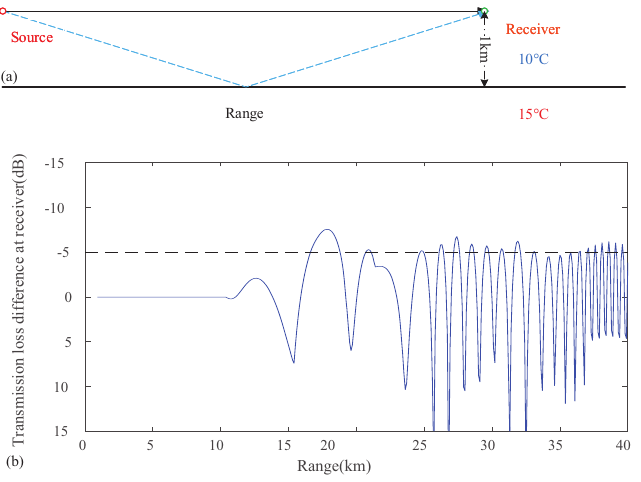
Figure 2. ( a ) A simplified model of front environment source and receiver located 1 km from xz-plane and ( b ) frontal reflection effects on the sound pressure field, the curve is the difference transmission loss between a direct wave and a direct plus horizontal reflected